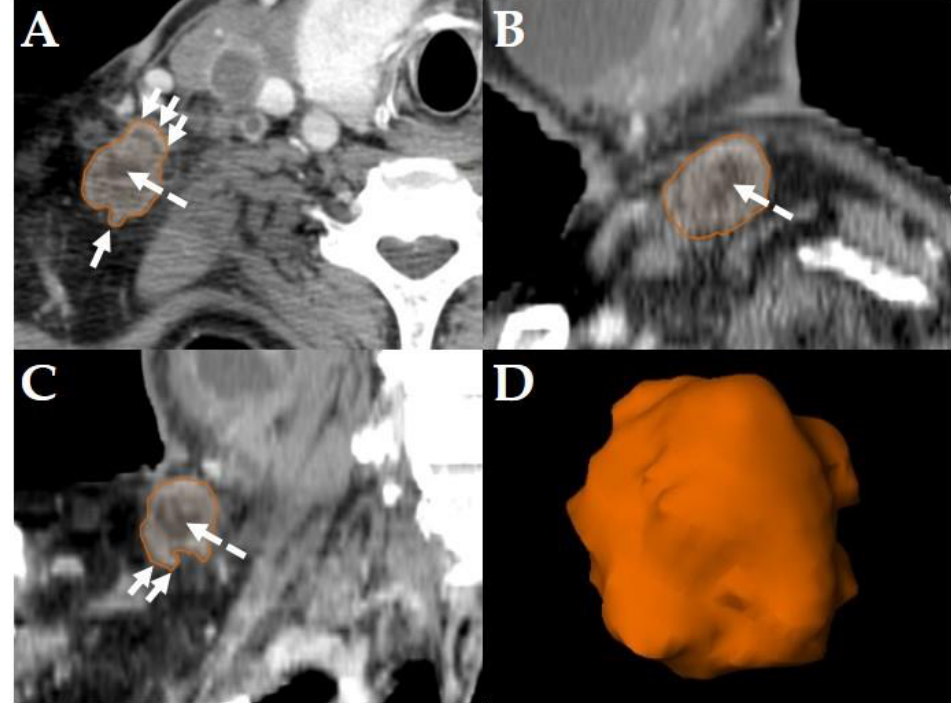
Figure 3. Example of a LN classified as “pathologic with ECS” in a Staging-CT of a 53-year-old, male HNSCC-patient of the oral cavity staged cT2 cN3b cM0. Manual segmentation in the axial plane ( A ); sagittal ( B ), coronal ( C ) reformatted views and three-dimensional rendering ( D ) of the LN are provided by the software. Solid arrows show soft tissue infiltration and an irregular LN capsule. Dashed arrows show central necrosis.